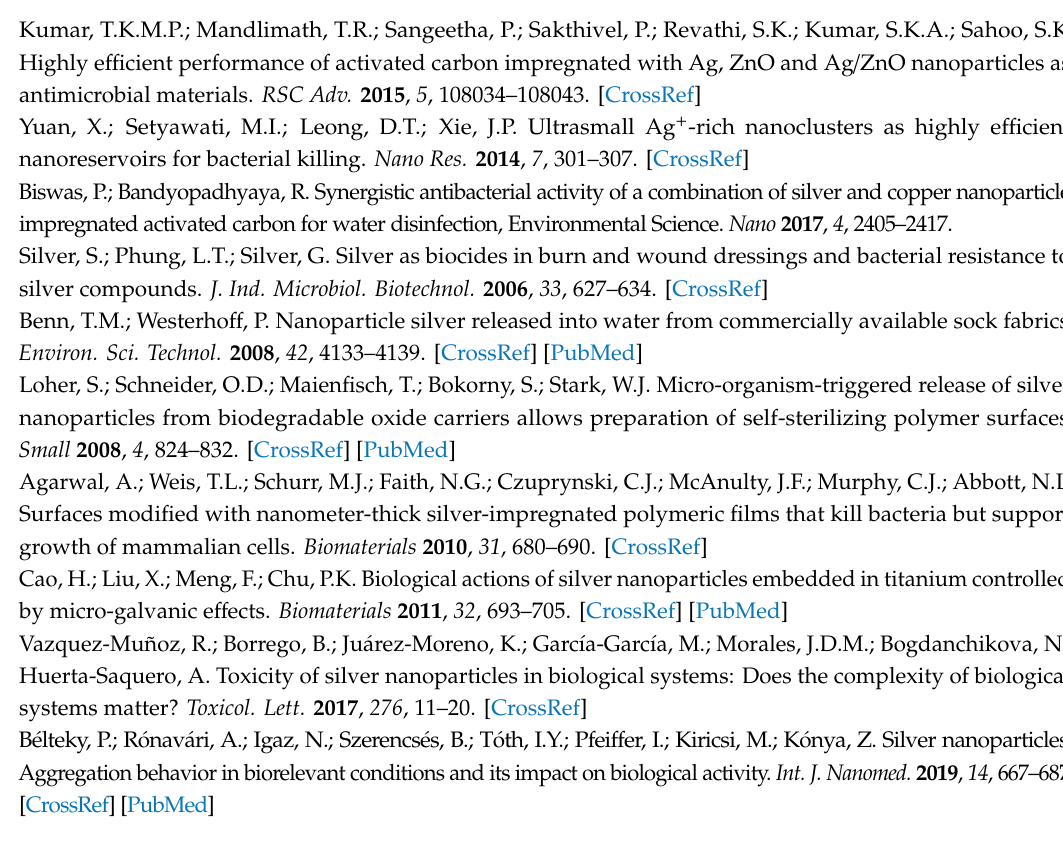
Figure S1: HRTEM image of (a) Ag / TNT-100_IN, (b) Ag / TNT-100_EL (0.1), and (c)–(f) Ag / TNT-100_NB (The circled regions in (e) and (f) represent the Ag NPs anchored to the inner surface of the TNTs. Moreover, in Figure S1(e) the Ag NP blocking the entrance to the TNT can be observed), Figure S2: EDS elemental mapping of (a) Ag / TNT-2.5_AM, (b) Ag / TNT-5_SH, (c) Ag / TNT-2.5_EL (1). Scanning transmission electron microscopy (STEM) images with red squares present the scanned area, Figure S3: HRTEM image of Ag / TNT-100_EL (1), Figure S4: (ii) Ag / TNT-100_AM, (iii) Ag / TNT-100_IN, (iv) Ag / TNT-100_NB, (v) Ag / TNT-100_EL (0.1), and (vi) Ag / TNT-100_EL (1), Figure S6: Antibacterial properties of Ag / TNTs with reference to Ag release from the hybrid